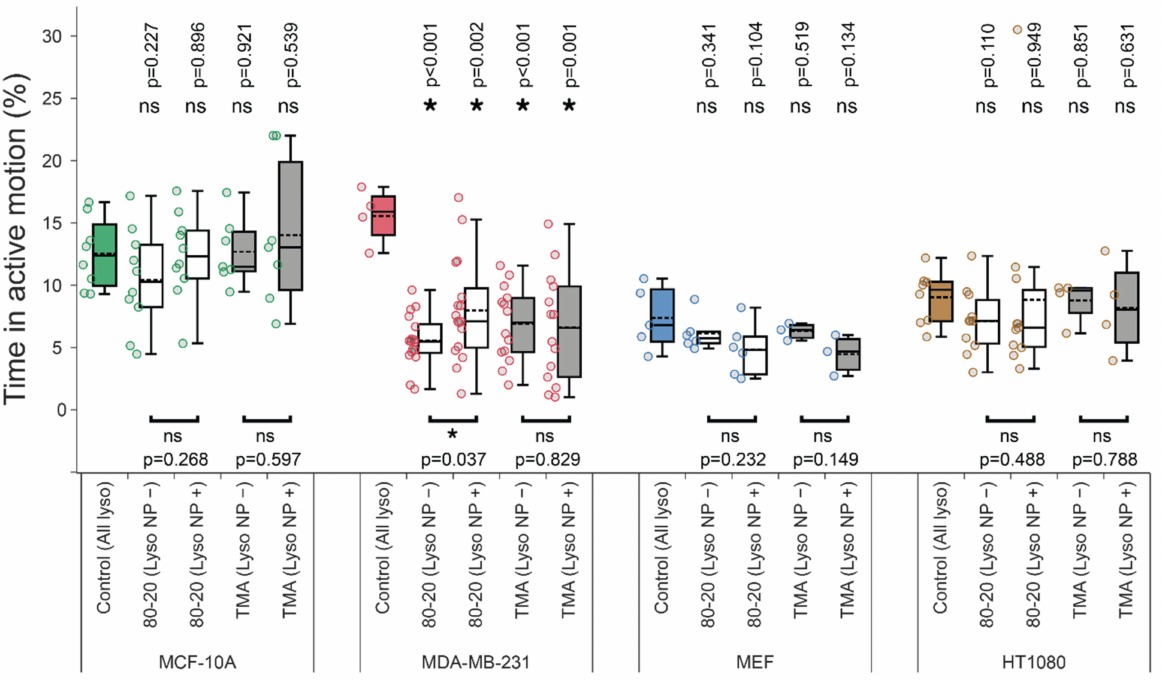
Figure 5. The effect of nanoparticle cargos on lysosome active transport. Time spent in active transport was computed after identifying active and passive trajectory segments with a wavelet- based approach. Note that for NP-treated samples, a wavelet-based co-movement algorithm (see Materials and Methods) was used to further subdivide lysosomes into those carrying NP cargos (Lyso NP+) and those without detectable cargos (Lyso NP − ). Asterisk or ‘ns’ indicated in the lower part of the plots indicate presence or absence of statistically significant differences, respectively, between parameters for lysosomes with or without cargos determined with two-tailed paired Student’s t test (* p < 0.05). Similarly, asterisk or ‘ns’ above the box plots indicate statistical significance of the difference between lysosomes from cells treated with NPs (white and grey boxes) versus all lysosomes in untreated, control cells (colored boxes) determined using Wilcoxon–Mann–Whitney test. (* p < 0.05). All experimental details, statistical tests, and numbers of trajectories and cells analyzed are identical to Figure